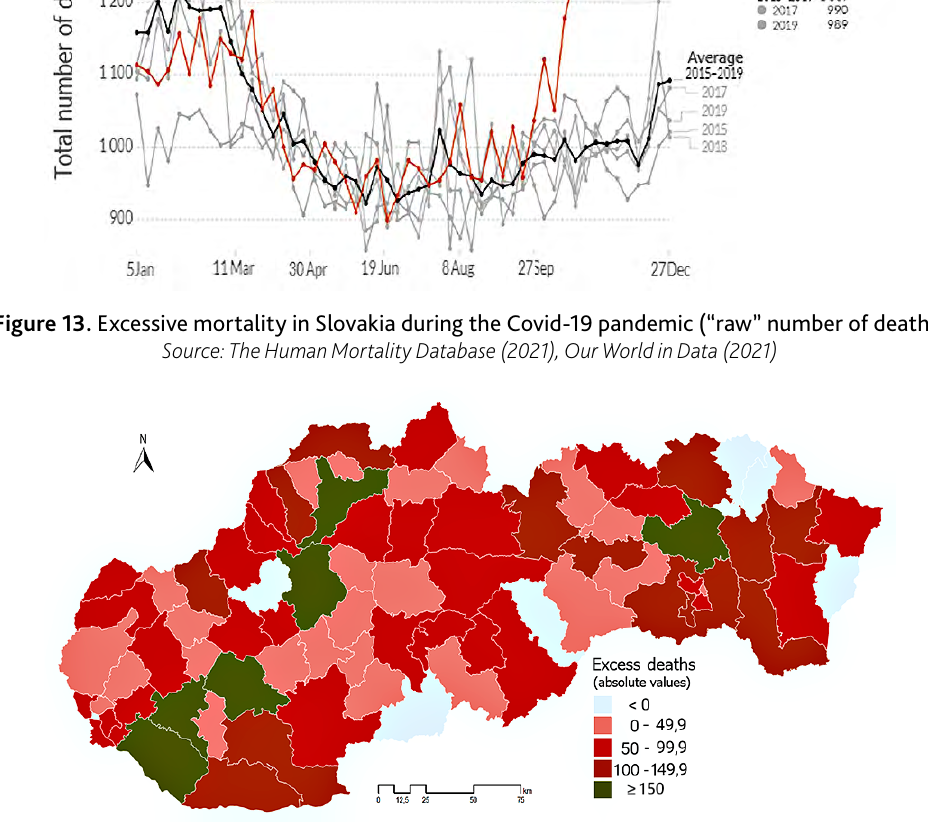
Figure 14. Excess deaths in districts of Slovakia in 2020 Source: ŠÚ SR